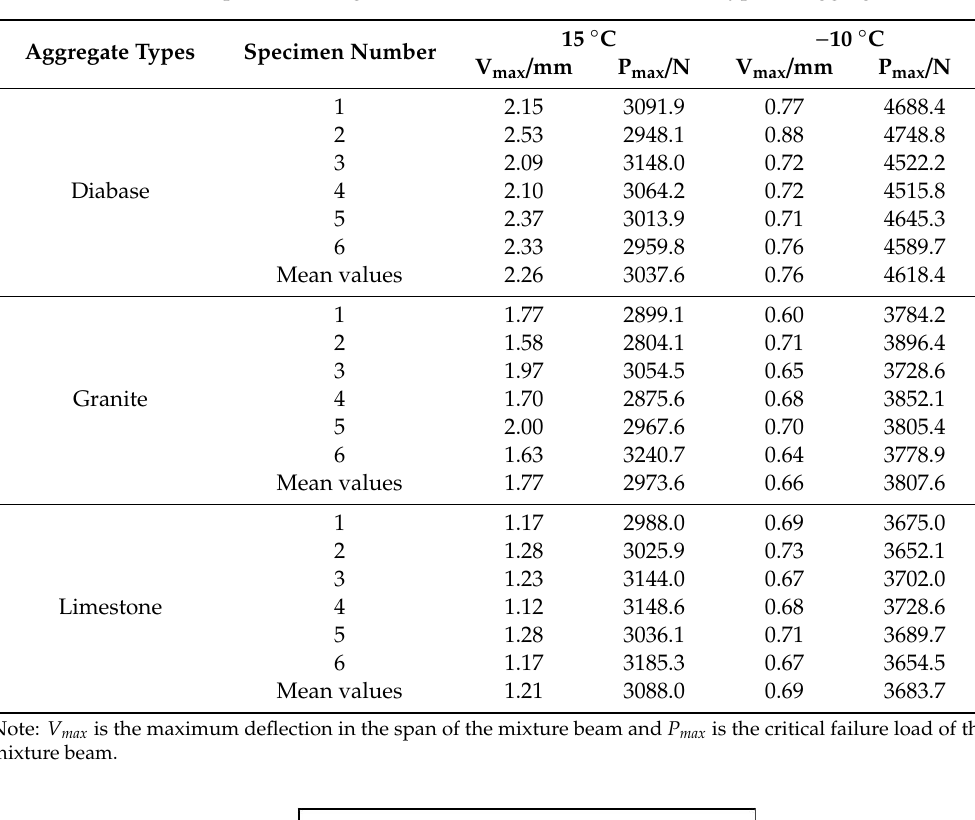
Figure 11. Three-point bending test results of three EAC beam types: ( a ) flexural tensile strength and ( b ) ultimate flexural tensile strain. 4.5. Impact Toughness and Fracture Toughness The A K and K IC values of the three EACs are shown in Figure 12. The mixture A K increased with the temperature, whereas K IC increased as the temperature decreased. Thus, the temperature significantly influenced the A K and K IC values of the mixture. The A K value characterizes the ability of a mixture to resist flexural deformation, and the K IC value characterizes the resistance of the mixture to cracking. The diabase EAC had relatively high A K and K IC values at the two temperatures, indicating that the use of high-strength aggregates significantly improved the EAC flexural cracking resistance.